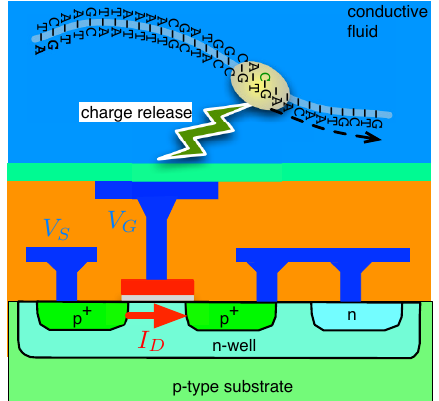
Figure 2. Sequencing-by-synthesis as achieved with ion-sensitive-field-effect-transistor (ISFET) charge